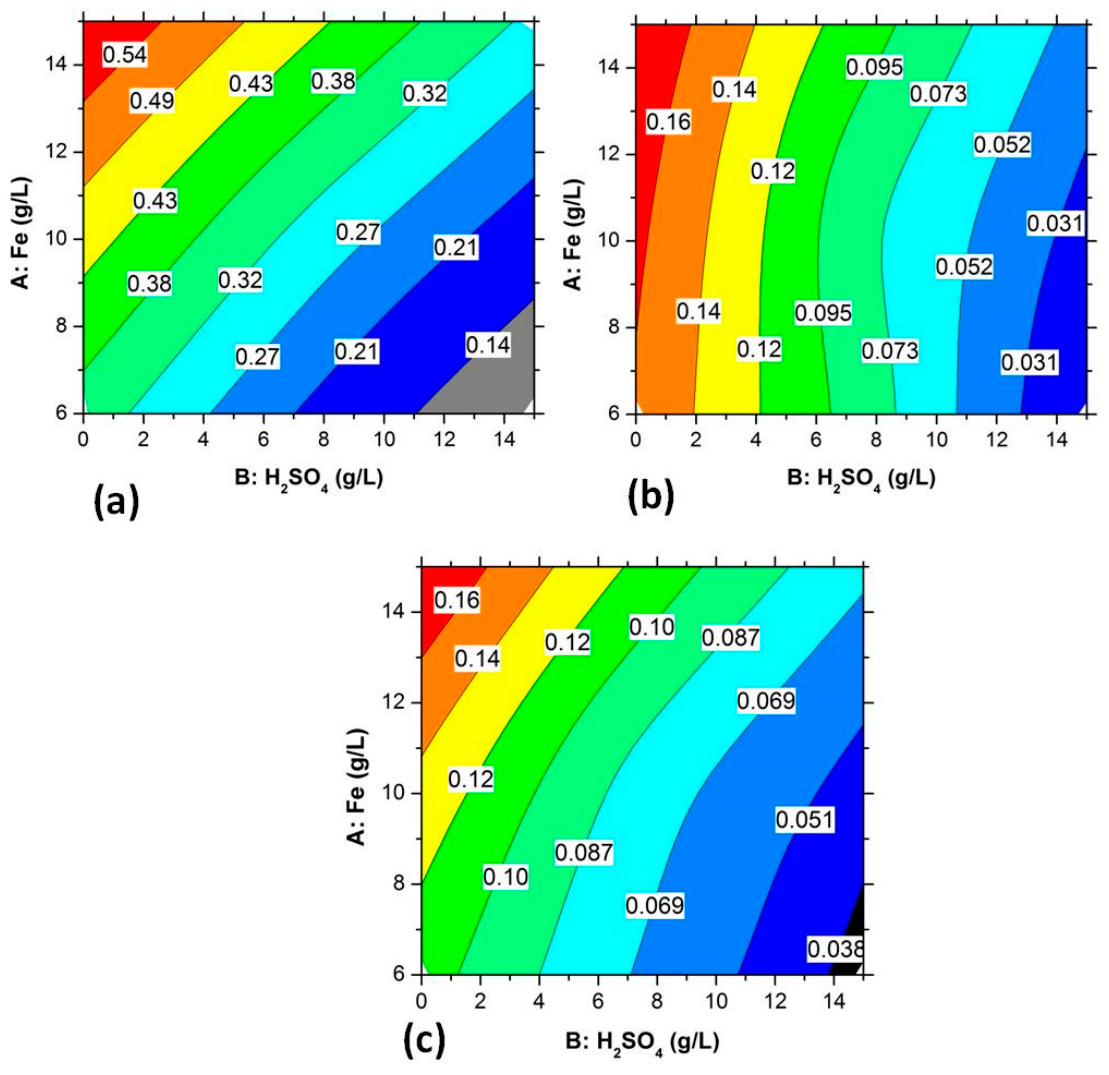
Figure 5. Cu / Fe ratio (%Cu / %Fe × 100) of precipitates plotted for the interaction e ff ects of initial H 2 SO 4 Figure 5. Cu/Fe ratio (%Cu/%Fe × 100) of precipitates plotted for the interaction effects of initial H 2 SO 4 and initial Fe(III) concentrations: ( a ) Seed = 0 g / L, ( b ) seed = 7.5 g / L, ( c ) seed = 15 g / L. and initial Fe(III) concentrations: ( a ) Seed = 0 g/L, ( b ) seed = 7.5 g/L, ( c ) seed = 15 g/L. Table 8. Initial and final conditions of the solutions and mineral phases of the precipitates.